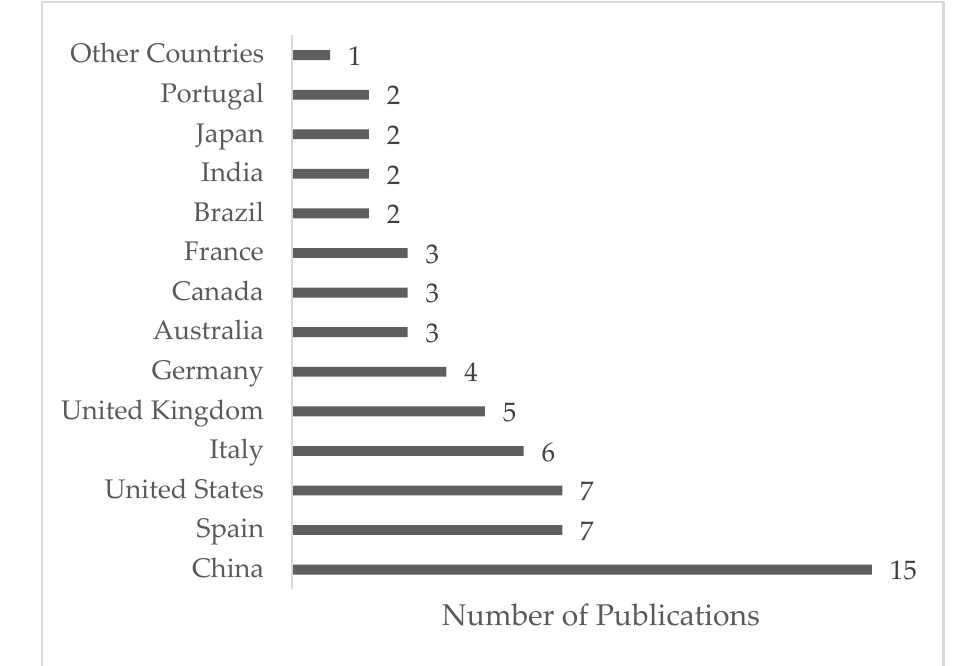
Table 4. Subject areas in the selected publications .